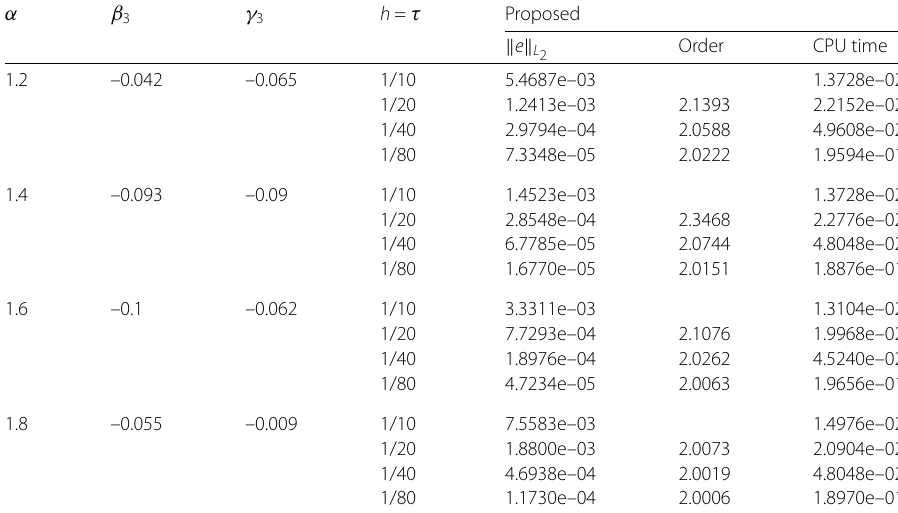
Table 7 Errors and corresponding observation orders at t = 1, λ = 0